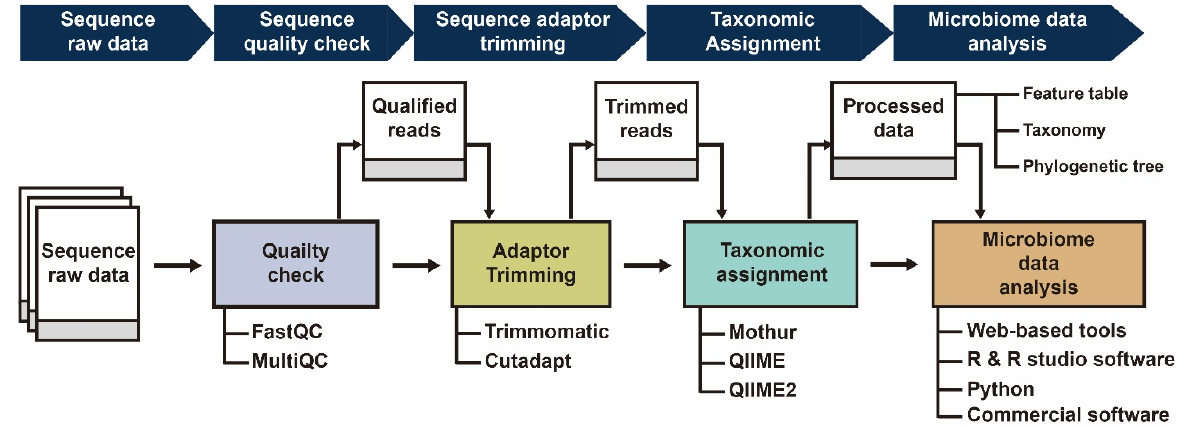
Figure 1. Graphical representation of the overall general workflow for analyzing 16S rRNA gene microbiome data.